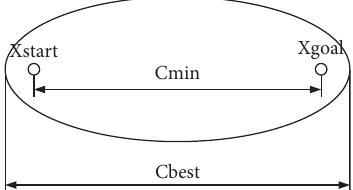
Figure 3: Schematic diagram of the Informed-RRT ∗ sampling area.